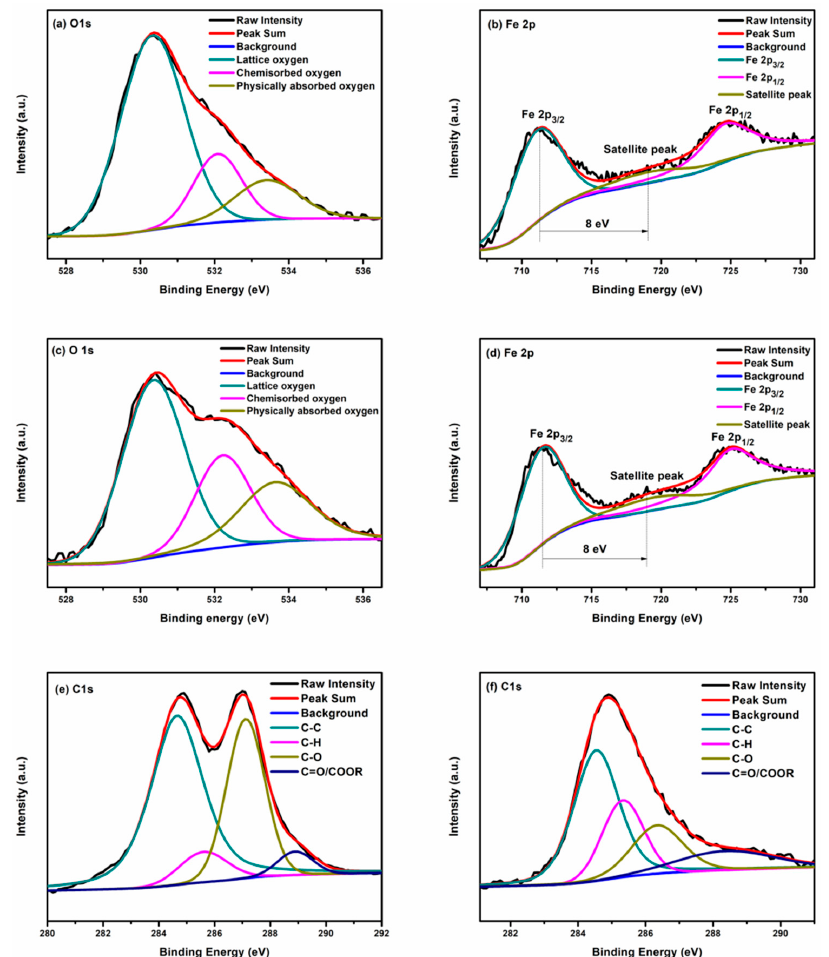
Figure 6. The high resolution spectrum of ( a ) O 1s for BFO; ( b ) Fe 2p for BFO; ( c ) O 1s for BGO60; ( d ) Fe 2p for BGO60; ( e ) C 1s for GO; ( f ) C 1s for BGO60.